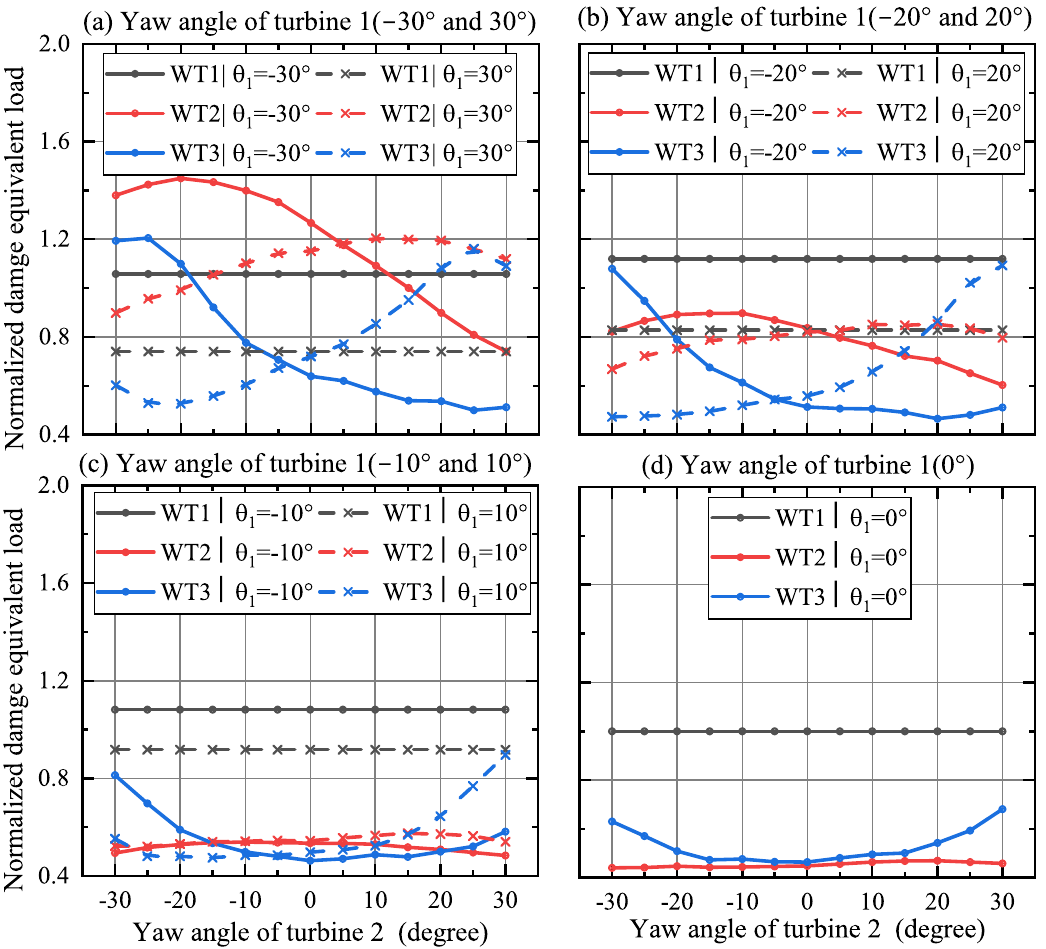
Figure 12. Blade root flapwise moment samples of normalized damage equivalent load under 9 m/s wind speed and 5% turbulence intensity. The damage equivalent load of turbine 1 under zero yaw offset case equals 1. The same axis scale is used in the four sub-pictures.